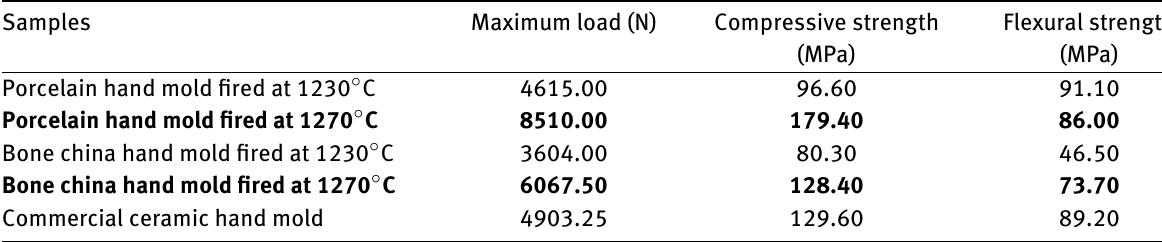
Table 6: Comparison of mechanical properties of porcelain, bone china and commercial ceramic hand mold samples